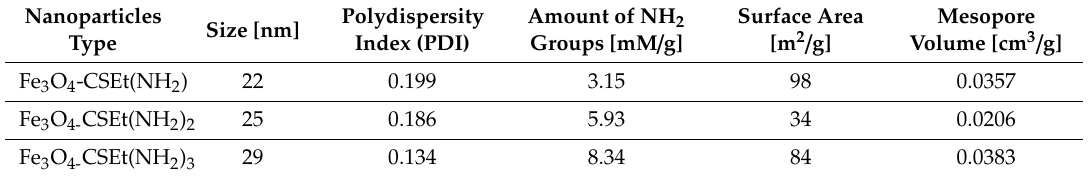
Table 1. Characterization of the prepared magnetic nanoparticles surface and